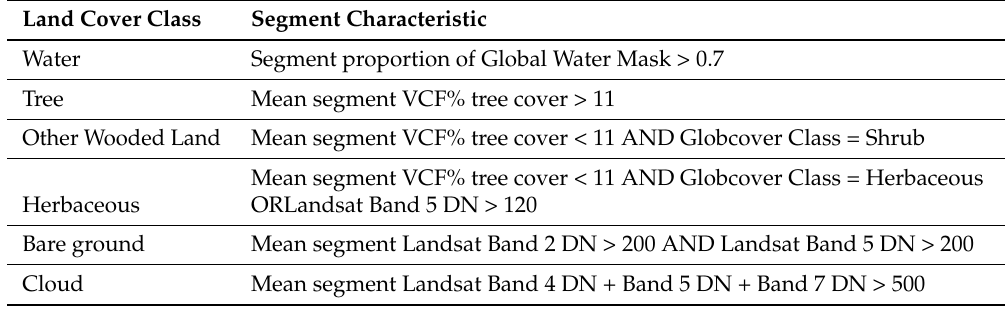
Table 1. Training segment labelling rules based on underlying MODIS VCF, GLOBCOVER, MODIS Water Mask and hard-coded Landsat DN thresholds. Landsat bands refer to those of Landsat-4, -5 TM and -7